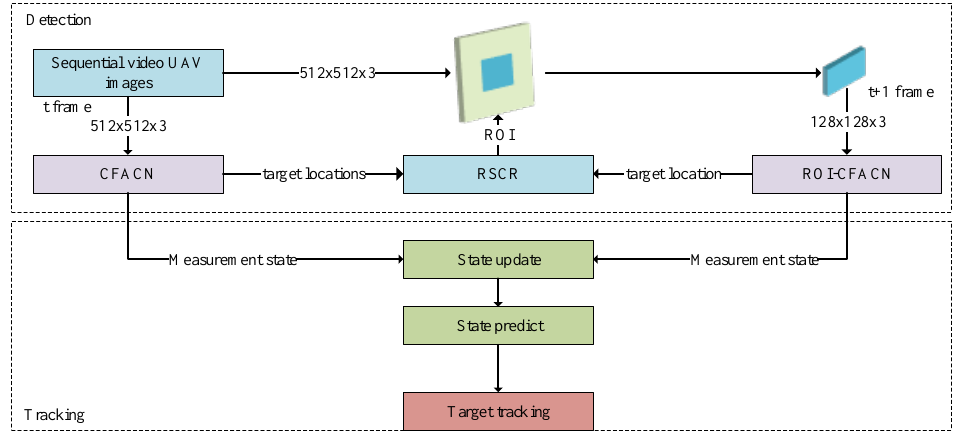
Figure 1. Flowchart of the proposed unmanned aerial vehicle (UAV) detection and tracking method. It consists of two parts: Detection and